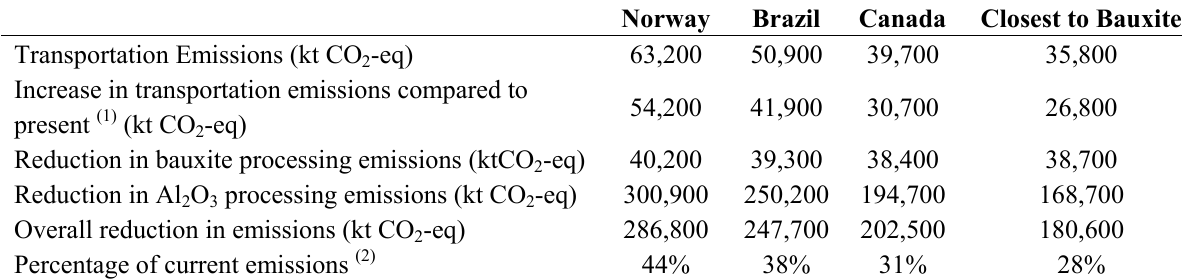
Table 8. Results of the aluminum industry